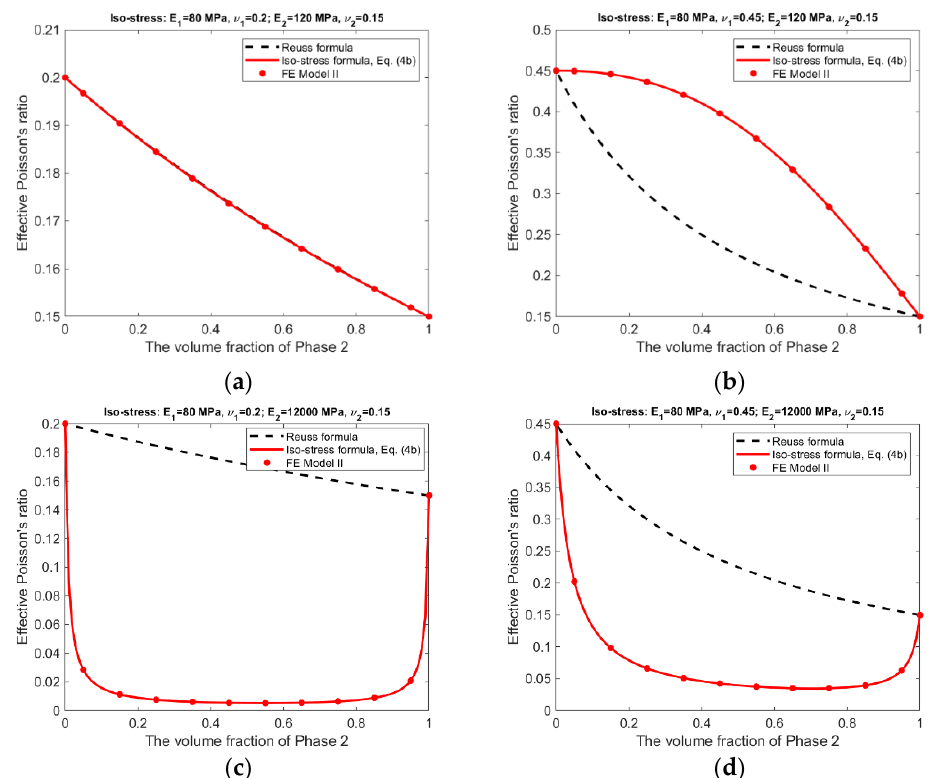
Figure 9. Iso-stress condition—Effective Poisson’s ratios predicted by analytical formulas and FEM. ( a ) Composite #1. ( b ) Composite #2. ( c ) Composite #3. ( d ) Composite #4.